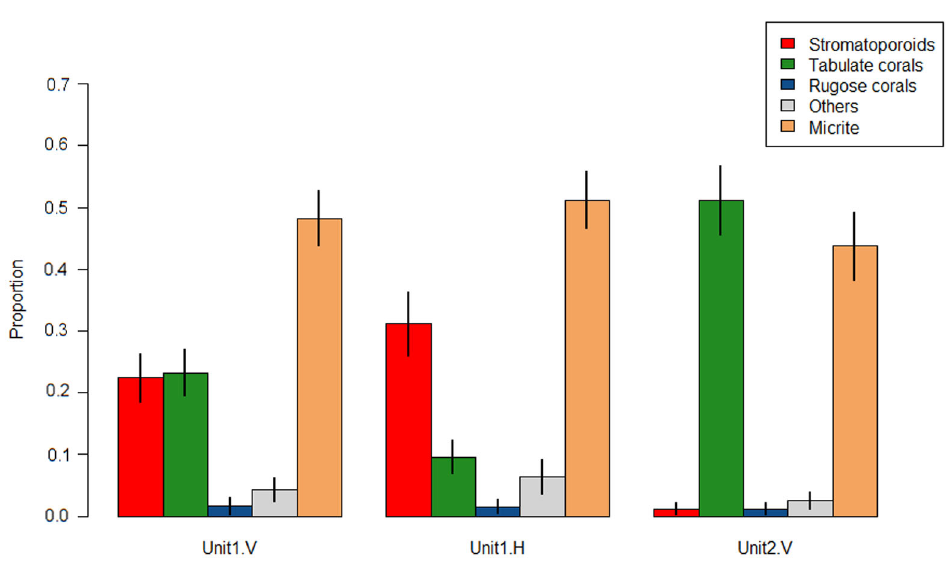
Fig. 3. Relative abundance of each component in the measured framework. Unit1.H, horizontal data from the first unit (120 points); Unit1.V, vertical data from the first unit (120 points); Unit2.V, vertical data from the second unit (80